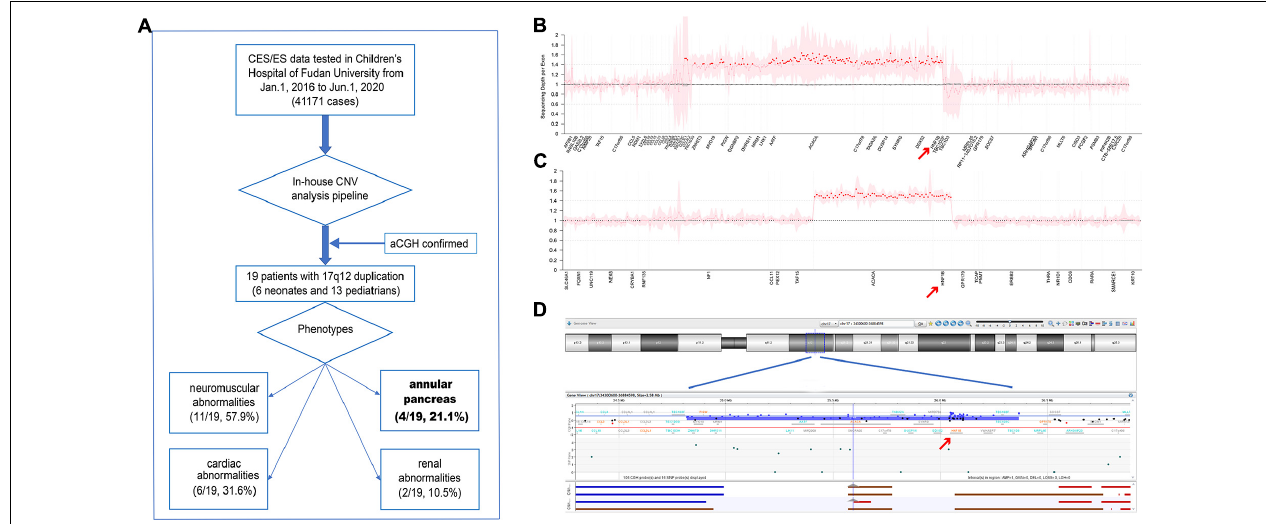
FIGURE 1 | (A) Flow diagram of this study. (B,C) Normalized sequencing depth of exons in samples with 17q12 duplication, for exome sequencing (ES) (B) and clinical exome sequencing (CES) (C) samples, separately. Sequencing reads depth on each exon were normalized and summarized. The mean values were marked as dots (pink dots for normal regions and red dots for duplication regions), and 95% confidential interval was shown as pink shades. X-axis was re-scaled by exon numbers other than gene length. (D) 17q12 duplication verified in patient 5 by aCGH.